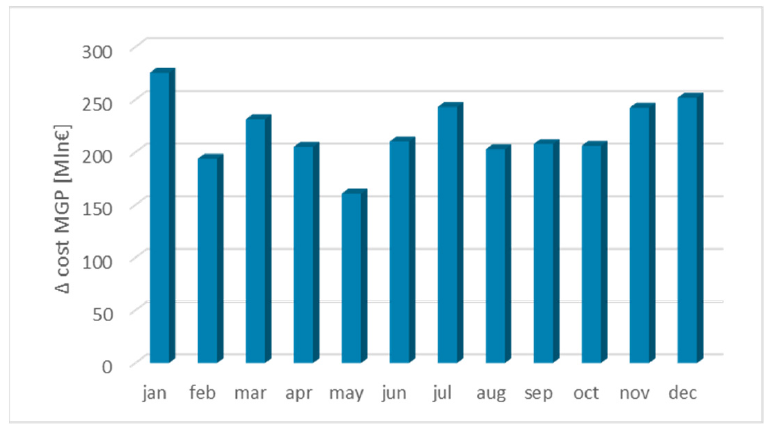
Figure 5. MGP cost increase when RR requirement is added to the MGP energy demand.